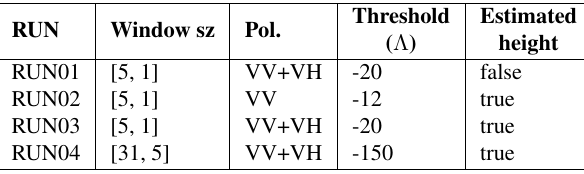
Table 2: Configuration for each RUN tested for the case study of Manchester.